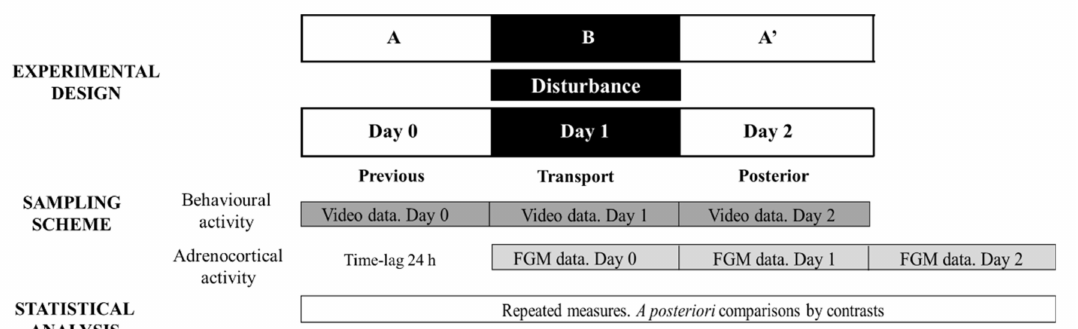
Figure 2. Representative diagram of the experimental and methodological approach used during Study 3 to evaluate transport effect on behavioural and adrenocortical activity. FGM = faecal glucocorticoid metabolites. The ABA experimental design applied: day 0 (previous-stage A), days 1 and 2 (disturbance—stage B) and day 3 (posterior-stage A (cid:48)